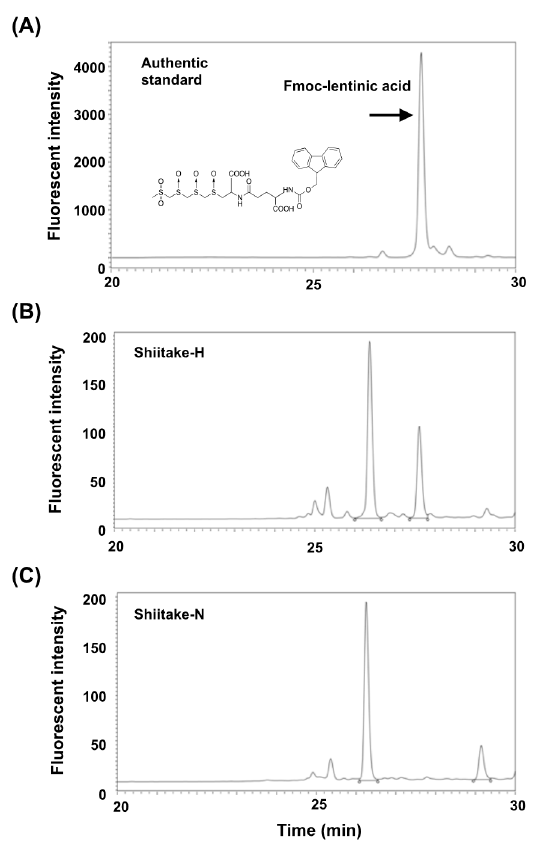
Figure 5. HPLC chromatograms of standard Fmoc-lentinic acid, Fmoc-amino compounds in Shiitake-H and Shiitake-N. ( A ) Standard; ( B ) Shiitake-H; ( C ) Shiitake-N.